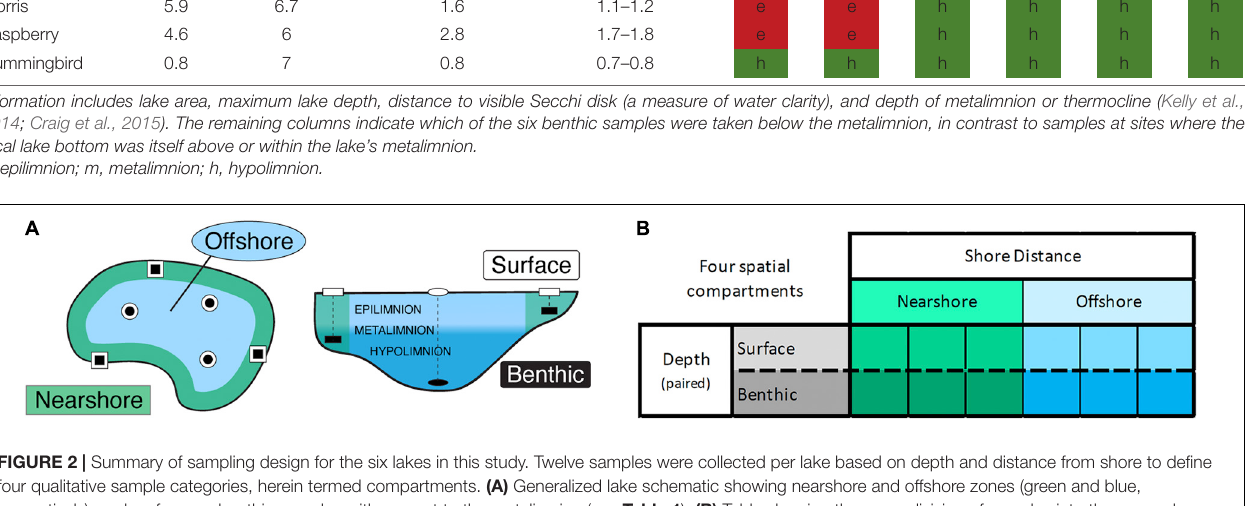
Deep samples below metalimnion